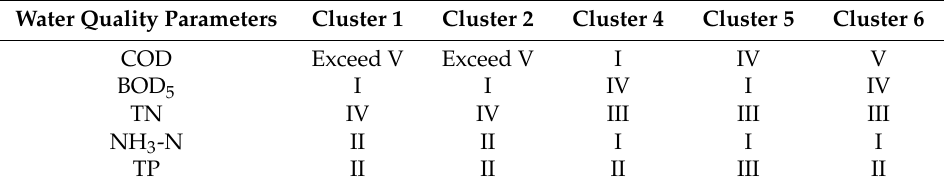
Table 1. The classes of water quality parameters in each cluster. COD: chemical oxygen demand; BOD: biological oxygen demand; TN: total nitrogen; NH 3 -N: ammonia nitrogen; TP: total phosphorus. Water Quality Parameters